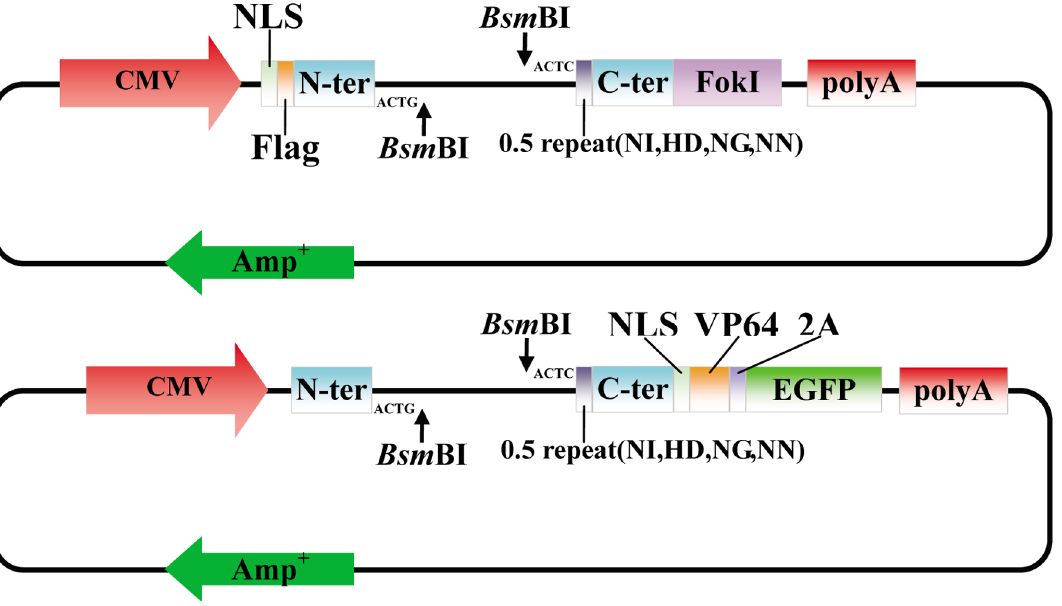
Figure 6. TALEN and TALE-TF expression backbones structure. The TALEN backbone contains a TALE DNA binding domain fused to the wild type FokI nuclease. The TALEN is expressed under the control of the CMV promoter. The TALE-TF backbone contains a TALE DNA binding domain fused to the VP64 transcription activator. Both the TALE-TF and EGFP are expressed under the control of the CMV promoter and they are divided by 2A. A TALEN or a TALE-TF backbone contain a 0.5 repeat that binds the final nucleotide of the targeted DNA sequence (according to the TALE binding site); thus both the TALEN backbones and TALE-TF backbones come as 4 different plasmids with 4 different 0.5 repeats.